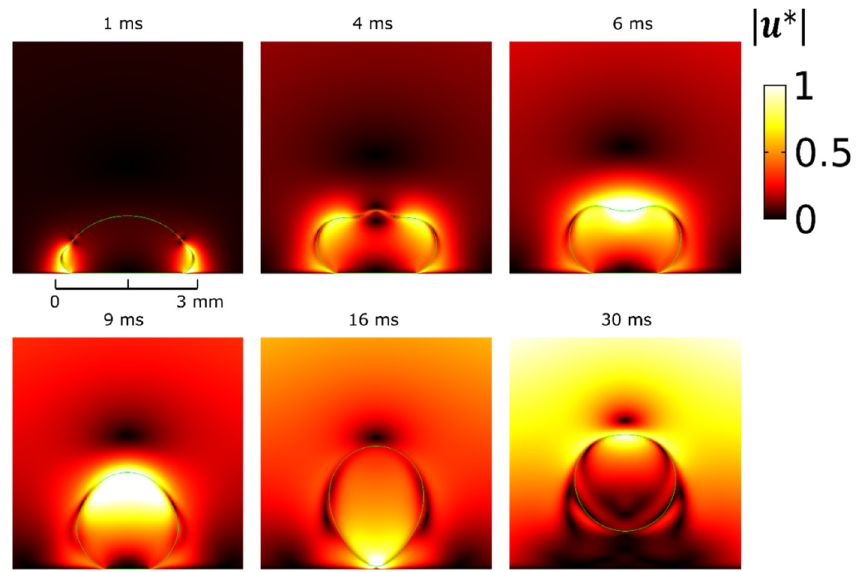
Figure 2. Time snapshots showing the dynamics during retraction, detachment and jumping of a 5.3 μL water droplet surrounded by oil as predicted by our numerical model. The dimensionless velocity magnitude |(cid:1873) ∗ | is visualized as a colormap.